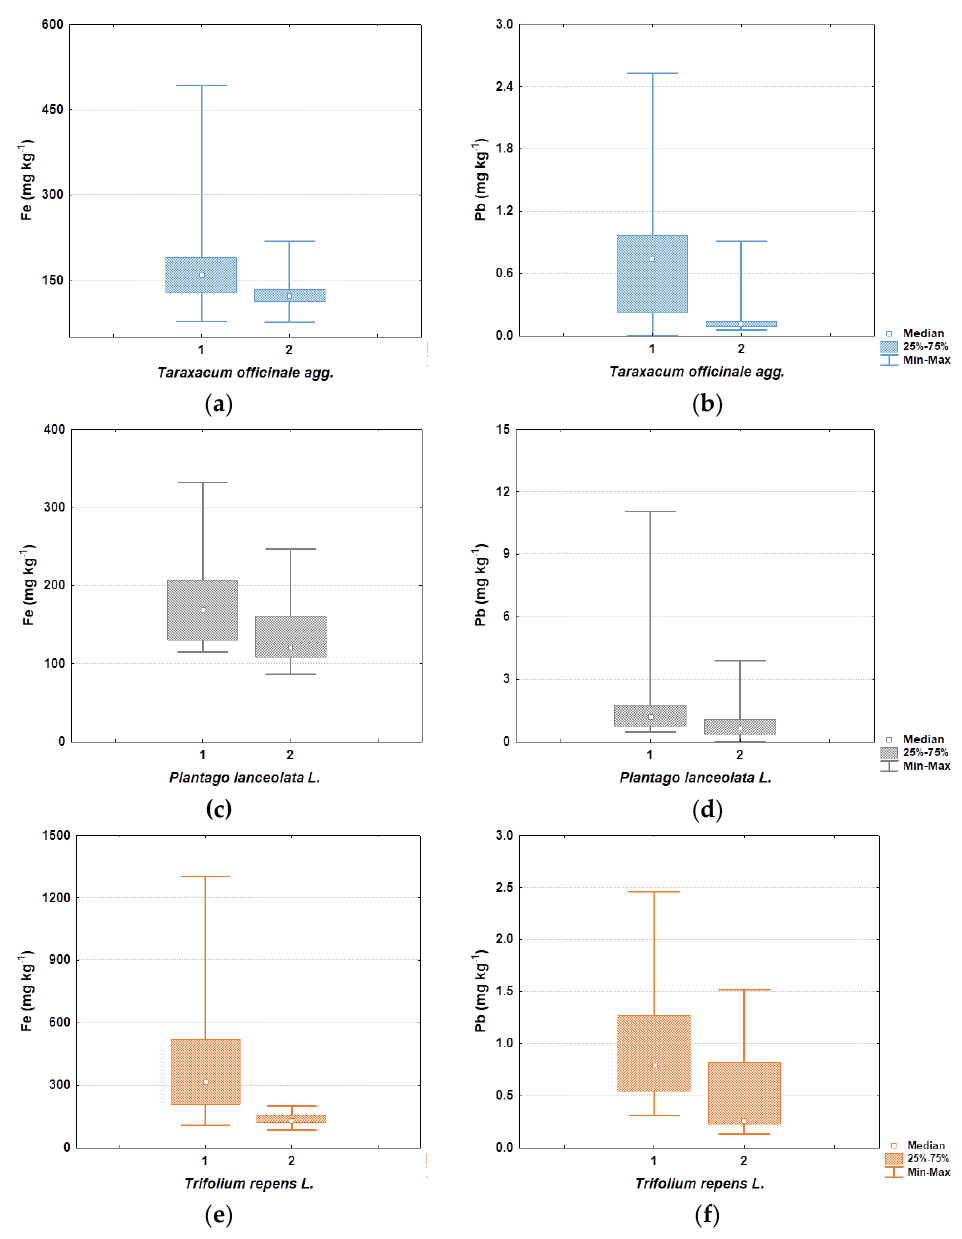
Figure 5. Boxplots showing differences in Fe and Pb content between unwashed (1) and washed (2) plant samples: ( a, b ) for Taraxacum offiicinale , ( c, d ) for Plantago lanceolata , and ( e, f ) for Trifolium plant samples: ( a , b ) for Taraxacum offiicinale , ( c , d ) for Plantago lanceolata , and ( e , f ) for Trifolium repens repens .